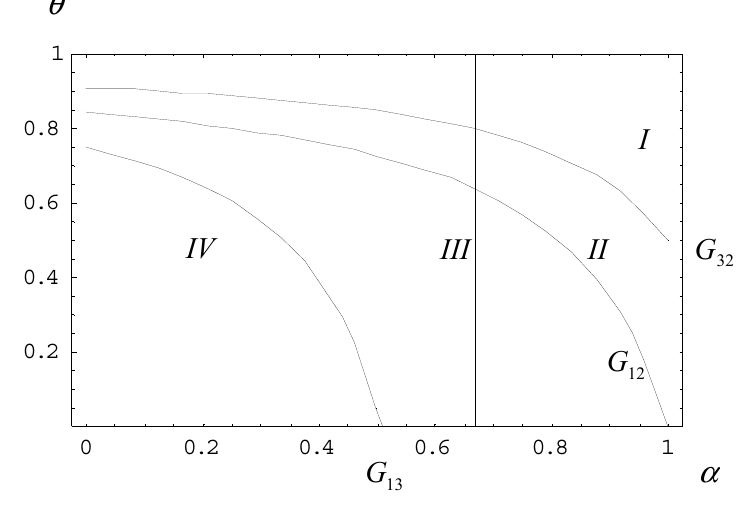
Figure 3. Decomposition of α , θ space for c l / c h = 0.2 .